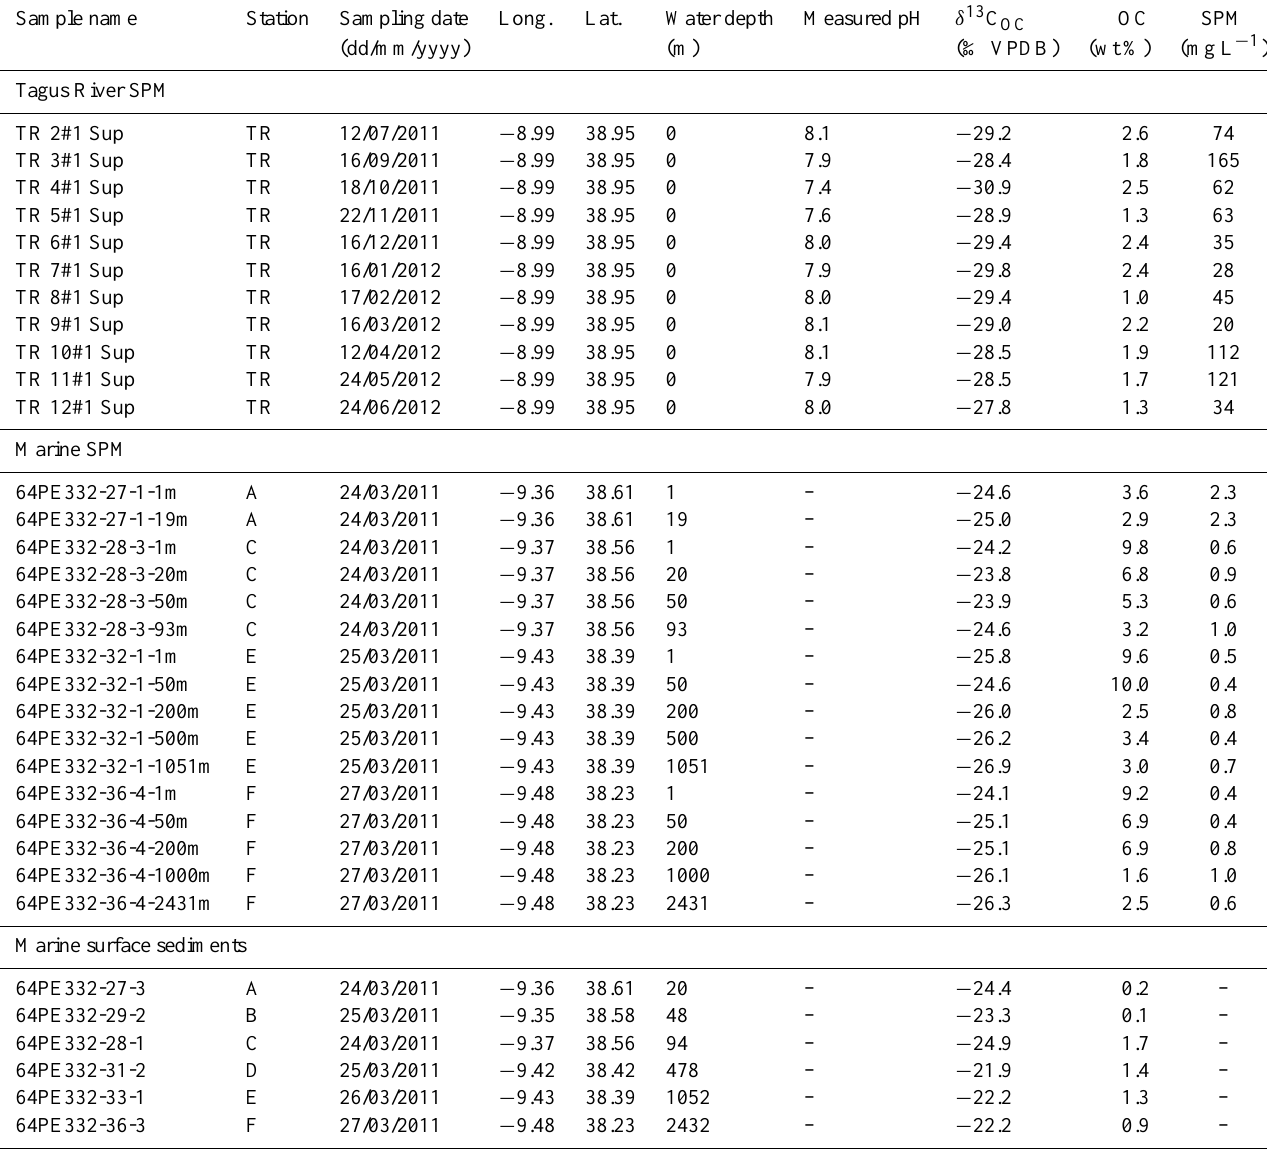
Table 2. Environmental and bulk geochemical data of soils and riverbank sediments collected in the Tagus River